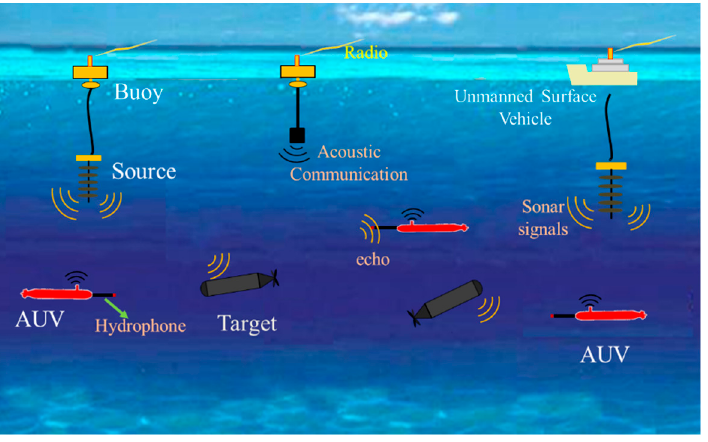
Figure 1. Multi-target tracking scenario in an underwater multi-static system using multiple AUVs.